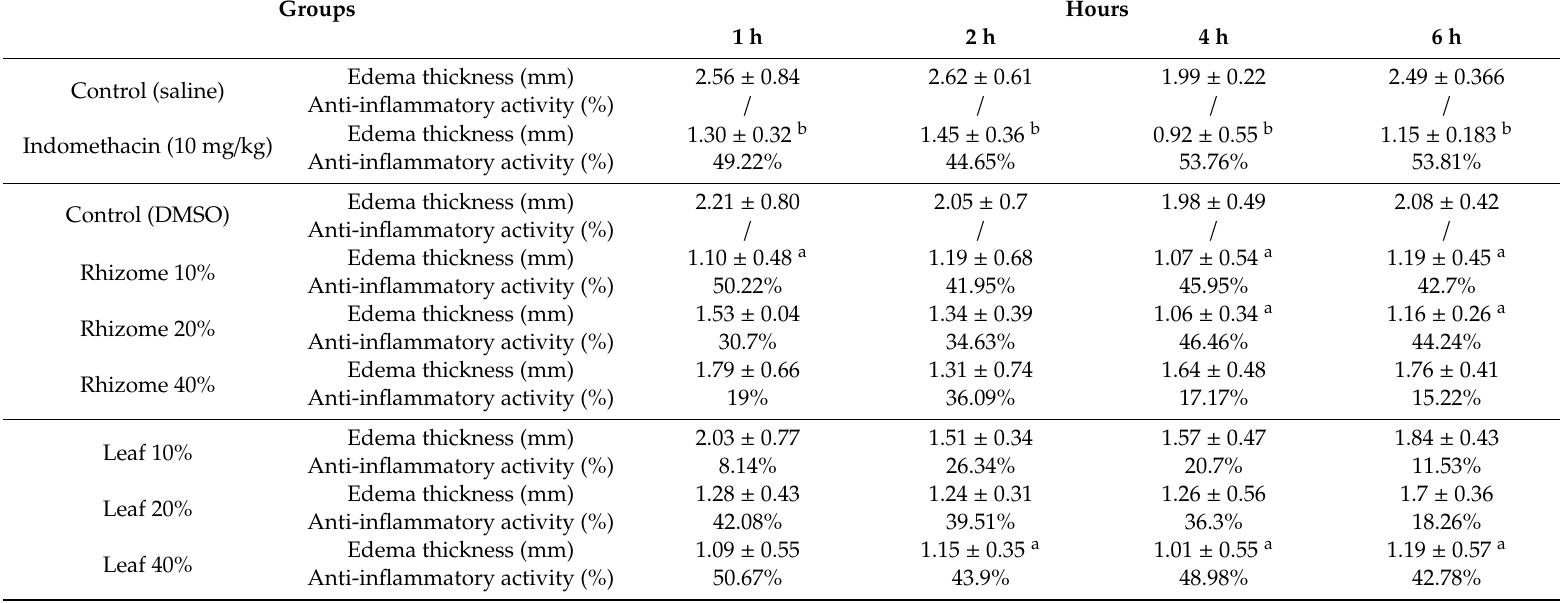
Table 4. Anti-inflammatory activity (in %) of essential oils obtained from rhizome and leaves of P. hybridus subsp. ochroleucus.